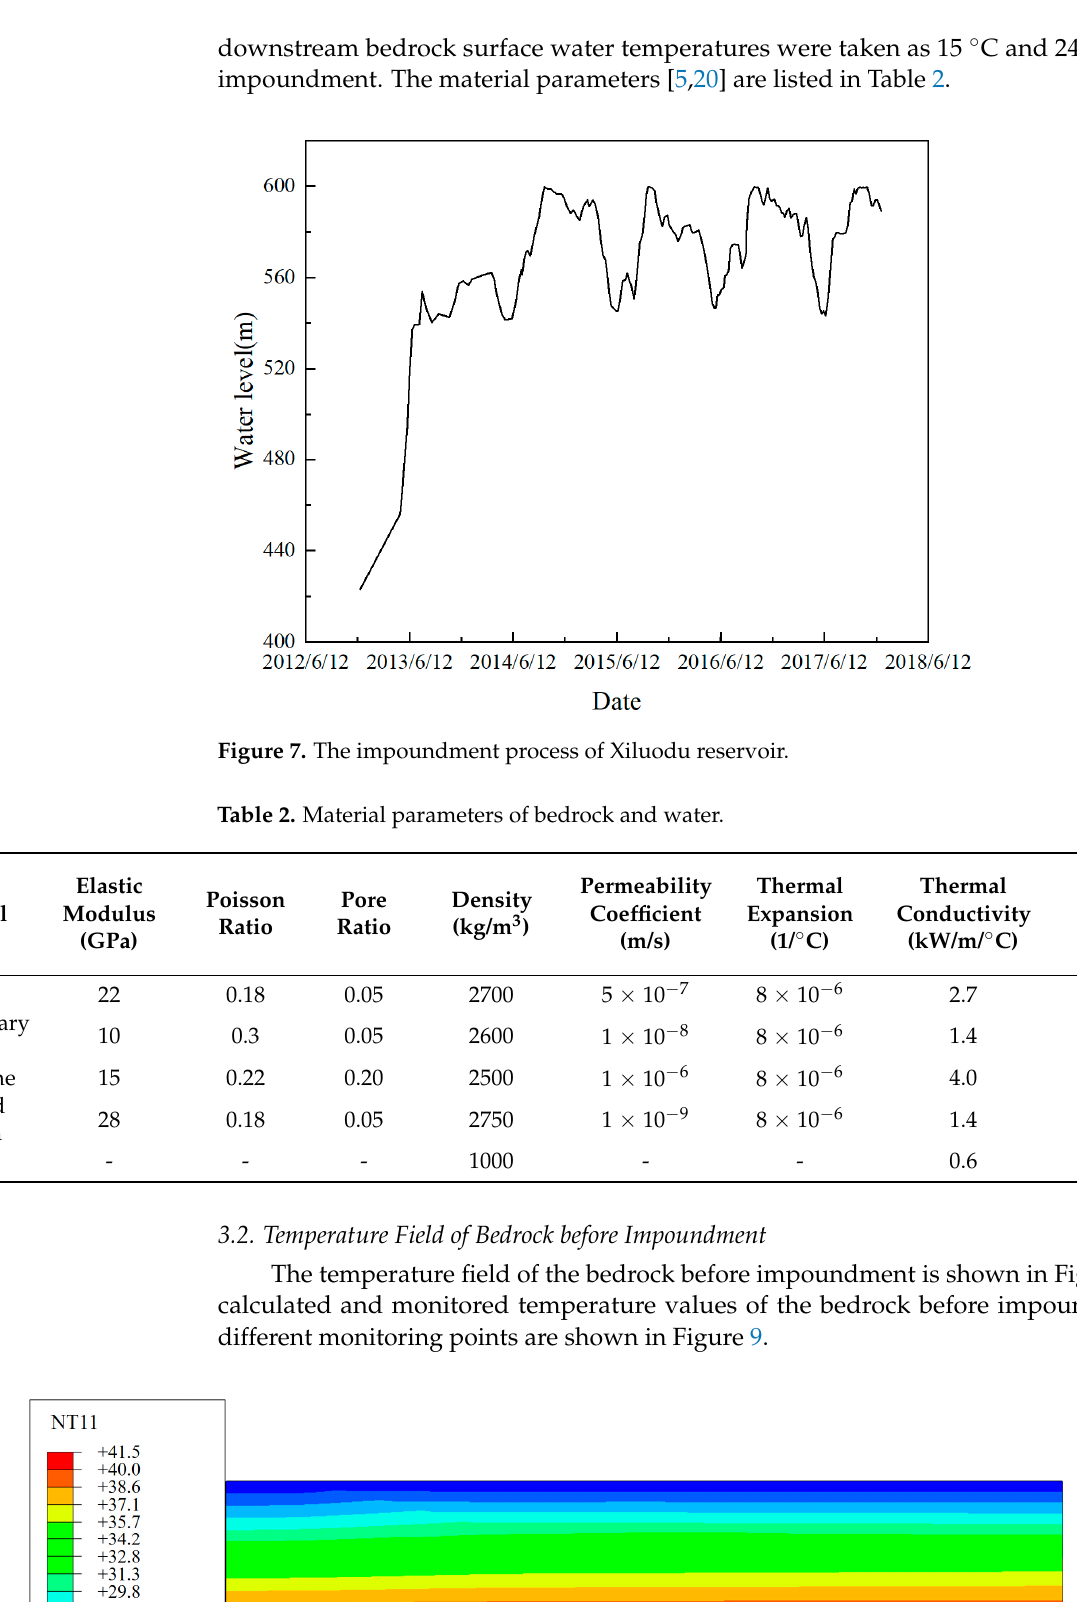
Figure 8. Temperature field of bedrock with a water level of 370 m before impoundment (unit: °C).